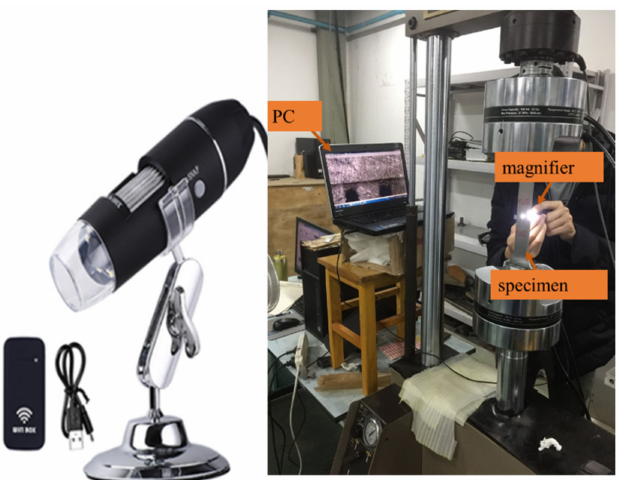
Figure 10. Experiments for collecting crack data: the left image shows the measuring magnifier used in the experiments, and the right image shows the experimental environment.